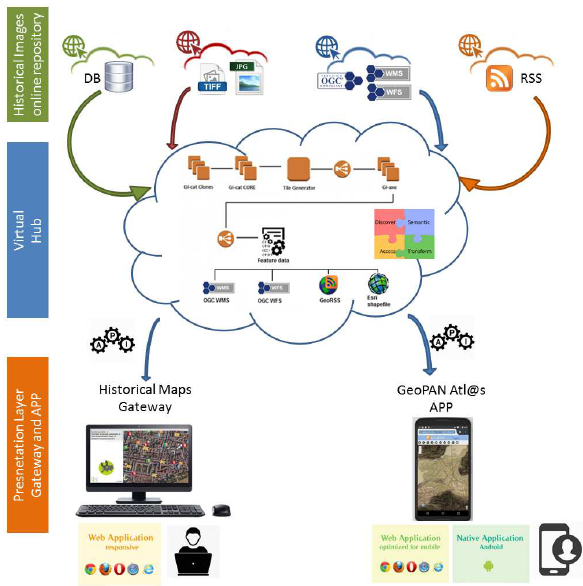
Figure 1. Architecture of the historical maps